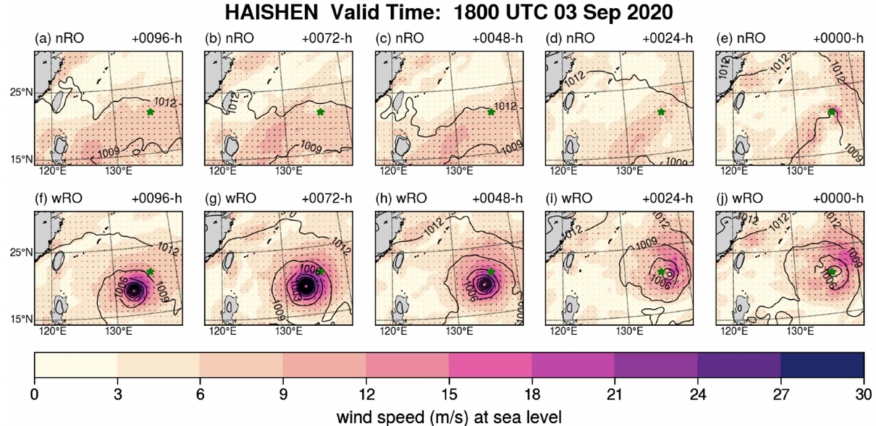
Figure 12. Typhoon Haishen initial conditions of lead times from 96 to 00 h within ( a – e ) nRO and ( f – j ) wRO validated at 1800 UTC on 3 September 2020. The green star signs denote the central positions of the best track, where the central pressure is 940 hPa and the maximum wind speed is 45 m/s at this